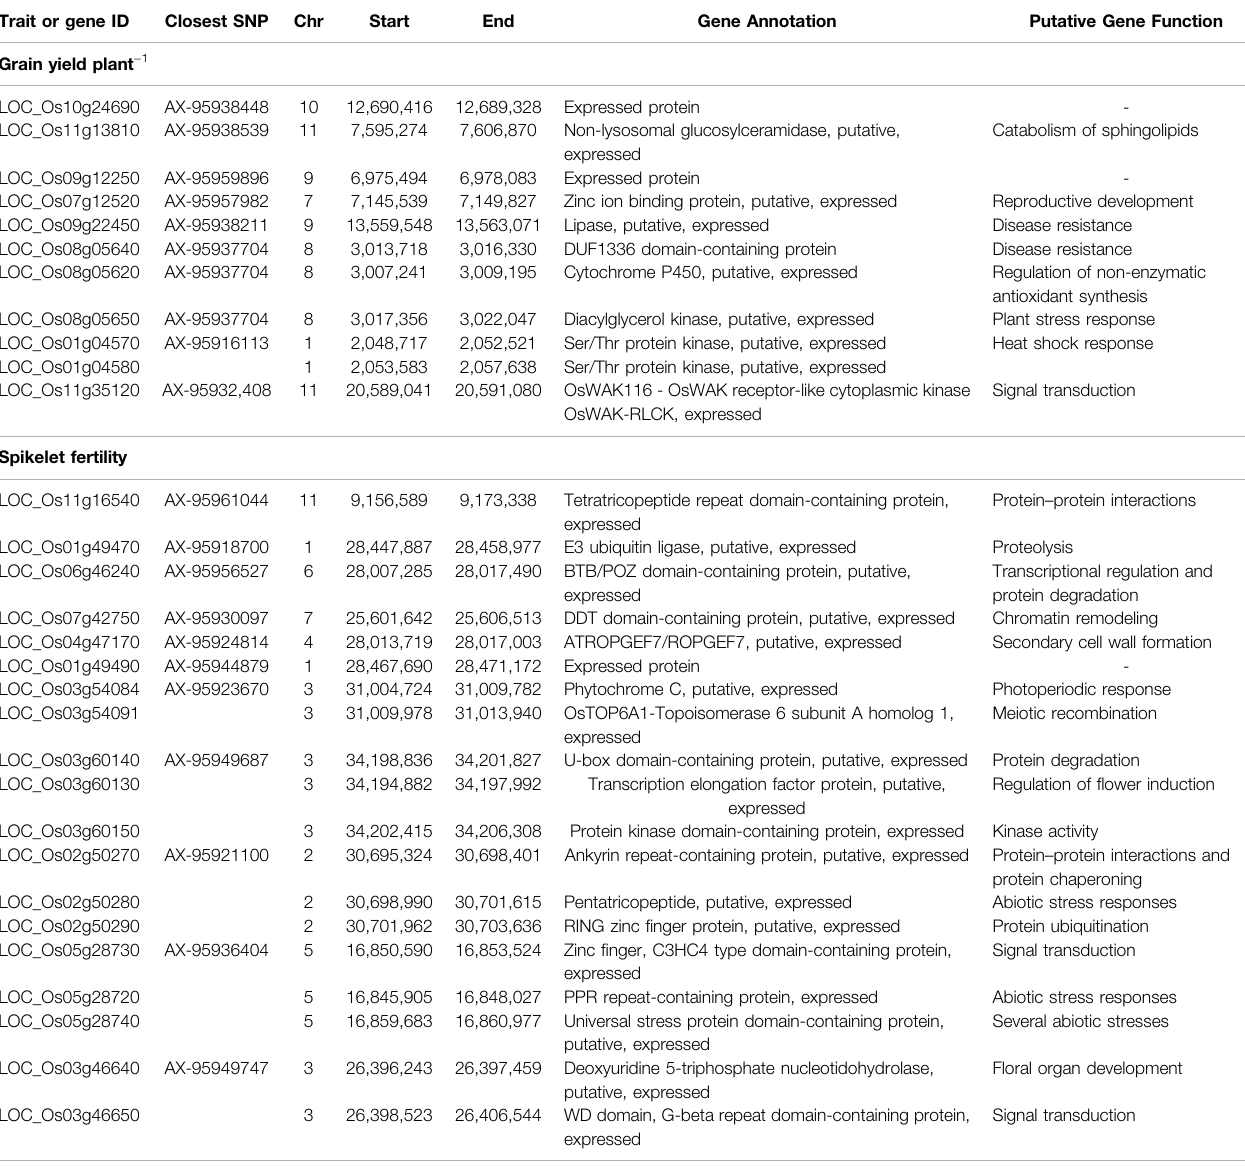
TABLE 3 | Candidate genes in the QTN regions identi fi ed through three GWAS models for grain yield per plant, spikelet fertility, and their respective stress tolerance index. Trait or gene ID Closest SNP Chr